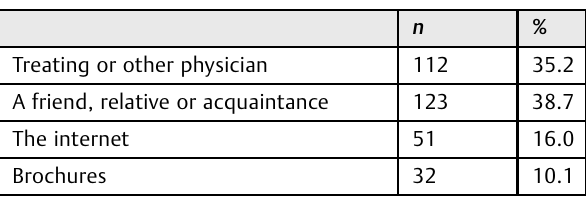
Table 4 Primary source of information on the association between VTE and cancer ( n ¼